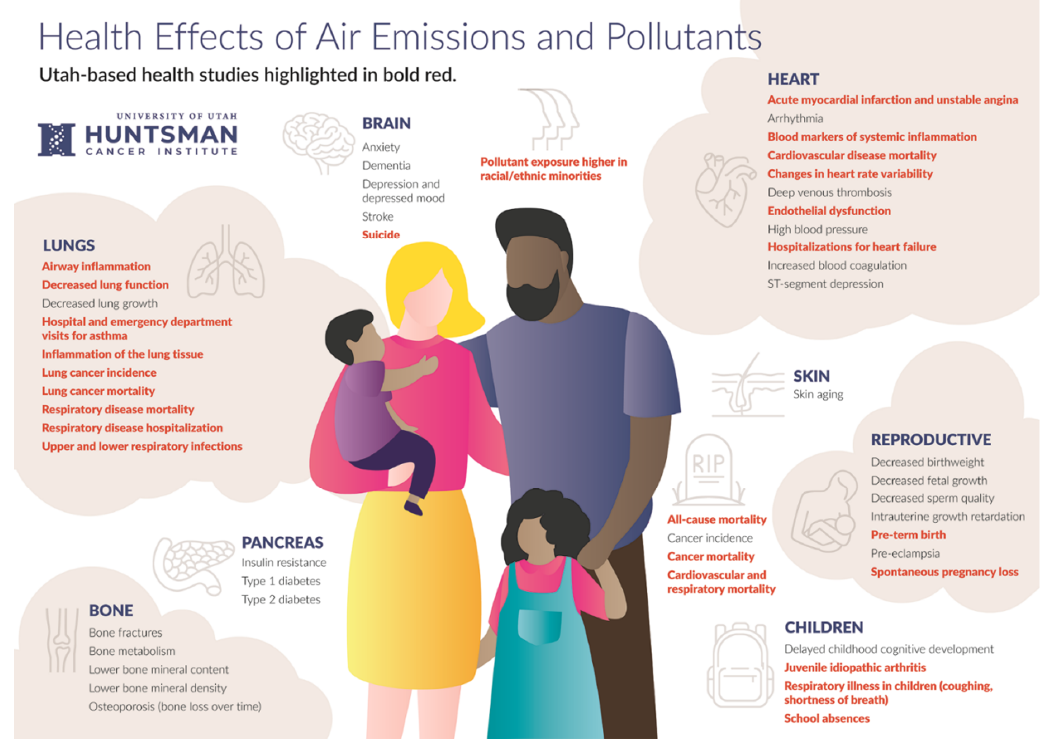
Figure 1. Health effects of air pollution (attached). Adapted from Thurston et al. 2017 [63] and The Utah Roadmap 2020 [64].